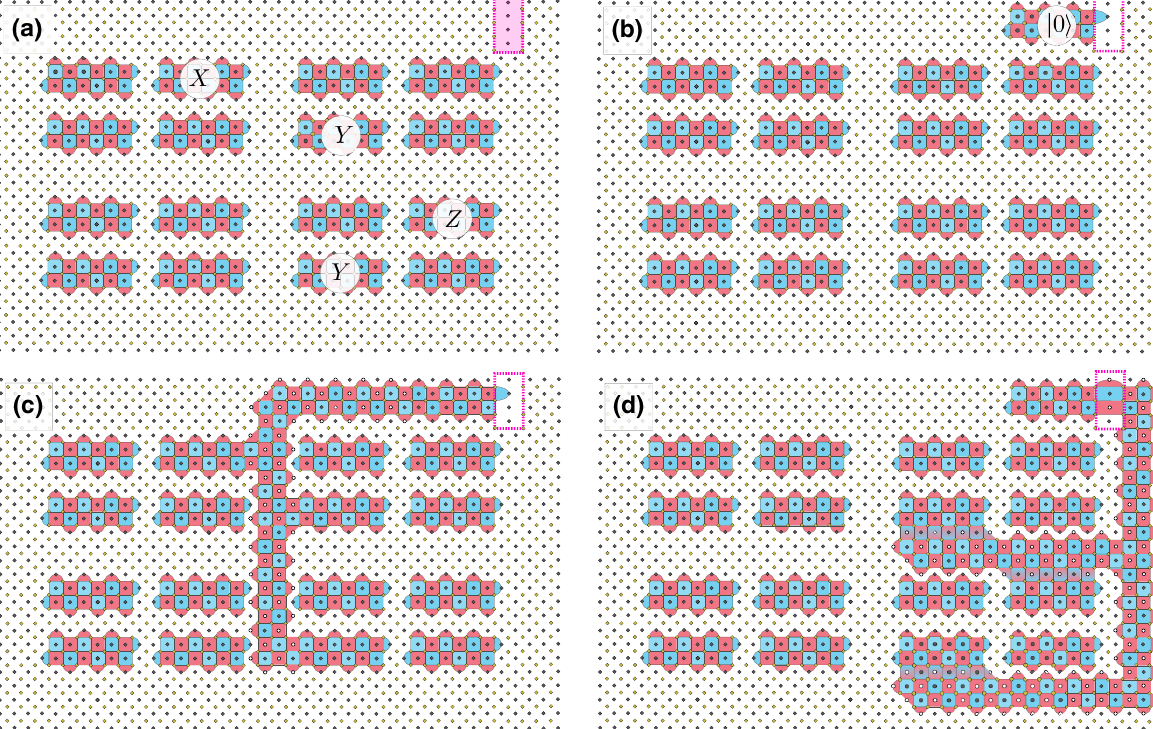
FIG. 11. An example of a 2D layout for a quantum computer and the implementation of twist-free lattice-surgery operations to realize a P = Y ⊗ Y ⊗ X ⊗ Z Pauli measurement, for which the circuit diagram is given in Fig. 10. (a) An initial layout of thin rectangular surface codes ( d x = 3 and d z = 7), with labels showing the Pauli operators to be measured. Note the pink rectangle where the hardware layout is slightly adapted to enable elongated stabilizer measurements just within this region. The space between surface- code patches is referred to as the routing space and is used in the subsequent steps. (b) The preparation of a logical | 0 (cid:3) state in the routing space. (c) A lattice-surgery measurement of X ⊗ X ⊗ X ⊗ 1 ⊗ X . (d) A lattice-surgery measurement of Z ⊗ Z ⊗ 1 ⊗ Z ⊗ X , where at every Z logical boundary we use a domain wall and at the single X logical boundary we use elongated stabilizers within the pink region. In both steps (c) and (d), the parity of the logical Pauli measurement is determined by the product of the stabilizers marked with a white vertex, with corrections applied by the